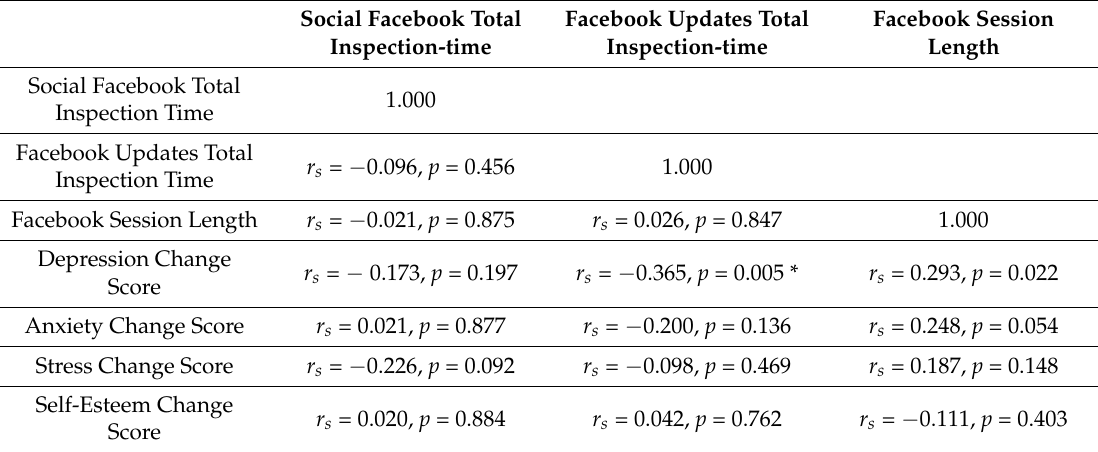
Table 3. Correlations between areas of interest, session length, and changes in depression, anxiety, and stress